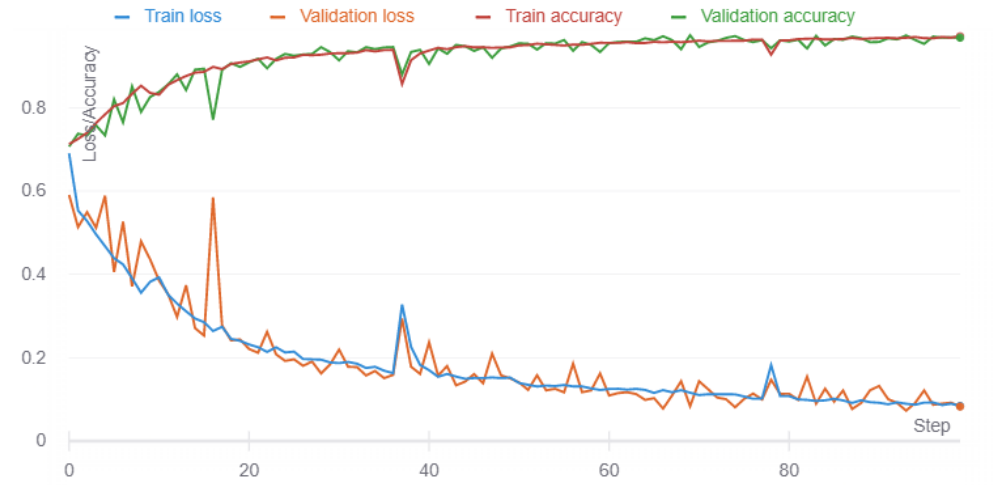
Figure 5. Training loss and accuracy as well as validation loss and accuracy from the dataset containing all the data. This pattern is representative of all leave-one-out batch training and indicates that the model has not overfitted the training set. Generated using “Weights and Biases” integration